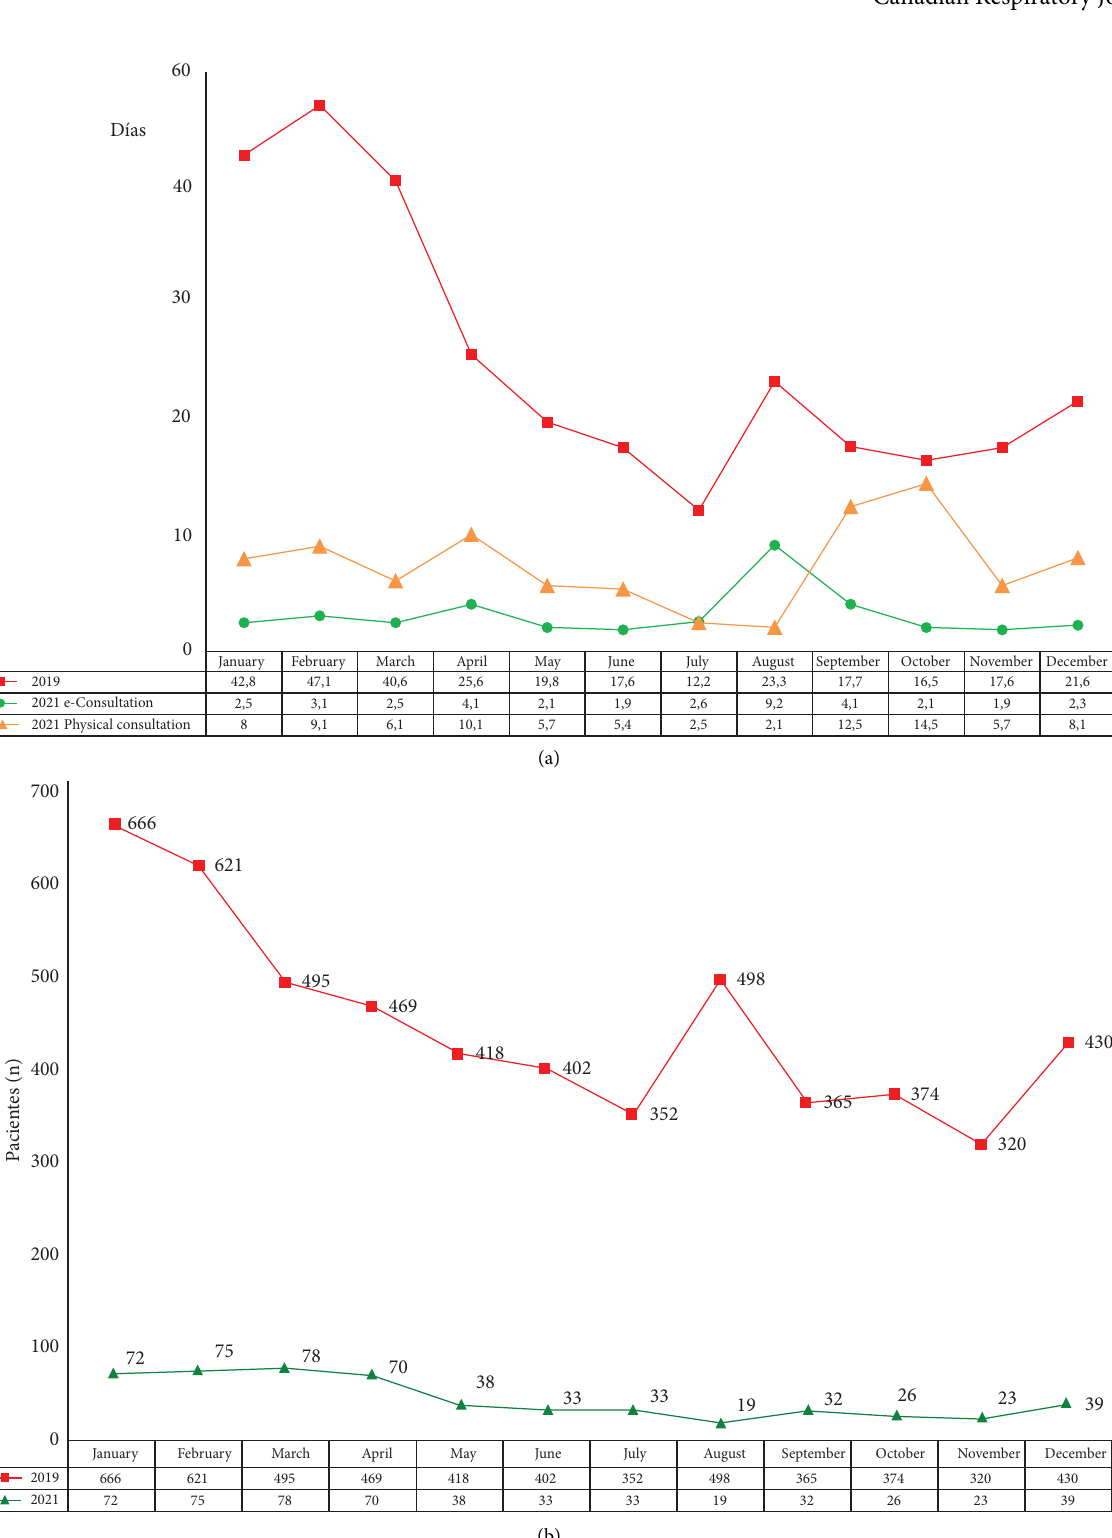
Figure 4: (a) Evolution of monthly mean wait time for frst appointment (2019), e-consultations, and frst face-to-face consultation. (b) Evolution of the number of patients in the waiting list for the frst appointment with the pulmonologist by months (2019 and